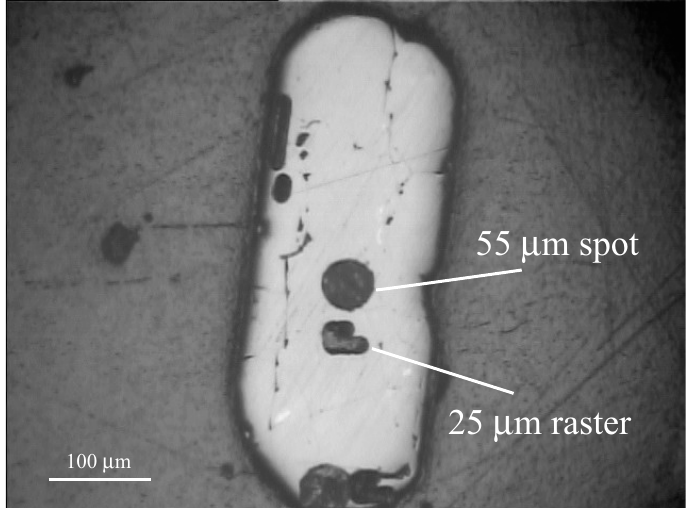
Fig. 2 – Example of zircon with two types of laser ablation pits produced by 25 mm raster and 55 mm spot modes, for U-Pb and Lu-Hf methods respectively. Laser spot for